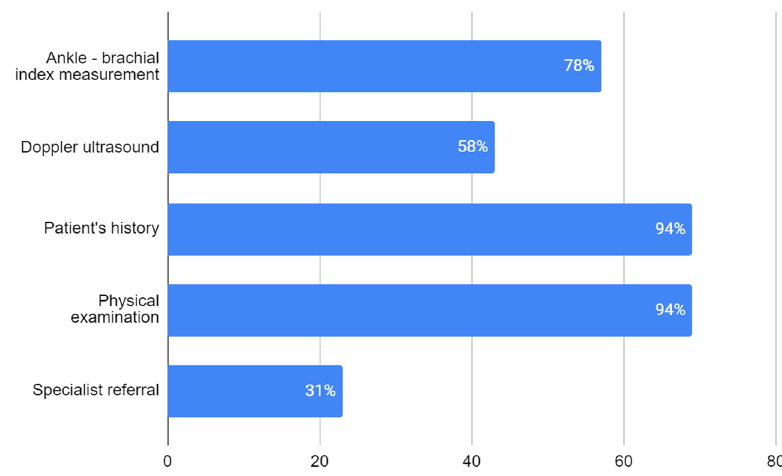
Figure 1. Respondents’ opinion on procedures necessary for diagnosis of LEAD (no. of responses). Percentage of respondents choosing each answer is given in white numbers.